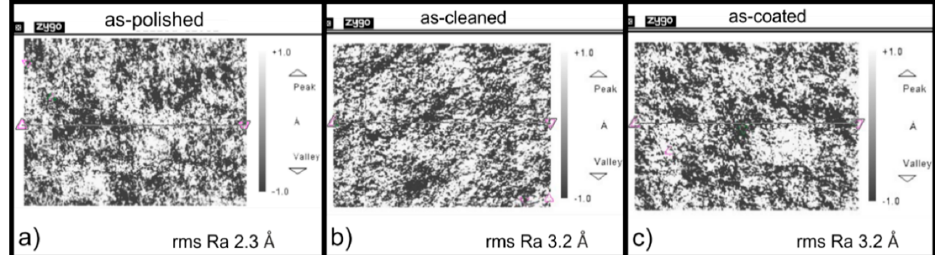
Figure 3. Plot of the white light interferometer measurements of ( a ) a polished sample, ( b ) a cleaned sample (CP 1; RMS roughness = 3.2 Å), and ( c ) a coated sample (CP 2; RMS roughness = 3.2 Å). Table 2. Root-mean-square (RMS) roughness of the as-polished, as-cleaned, and as-coated samples measured by means of a white light interferometer at WZW Optic AG. As-Polished